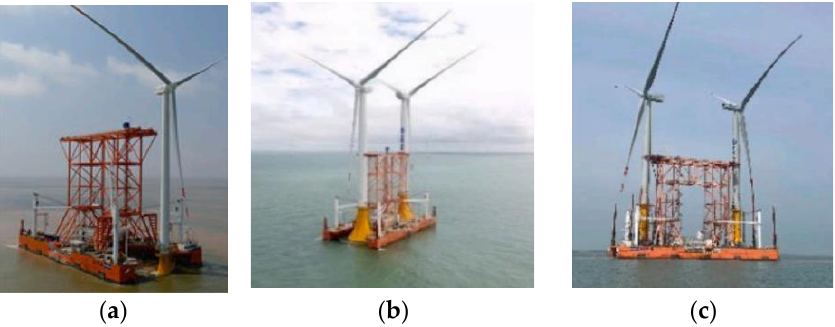
Figure 3. One step installation example of the composite bucket foundation. ( a ) Xiangshui wind farm (3.5 MW); ( b ) Dafeng wind farm (6.45 MW); and ( c ) Rudong wind farm (4 MW). (3.5 MW); ( b ) Dafeng wind farm (6.45 MW); and ( c ) Rudong wind farm (4